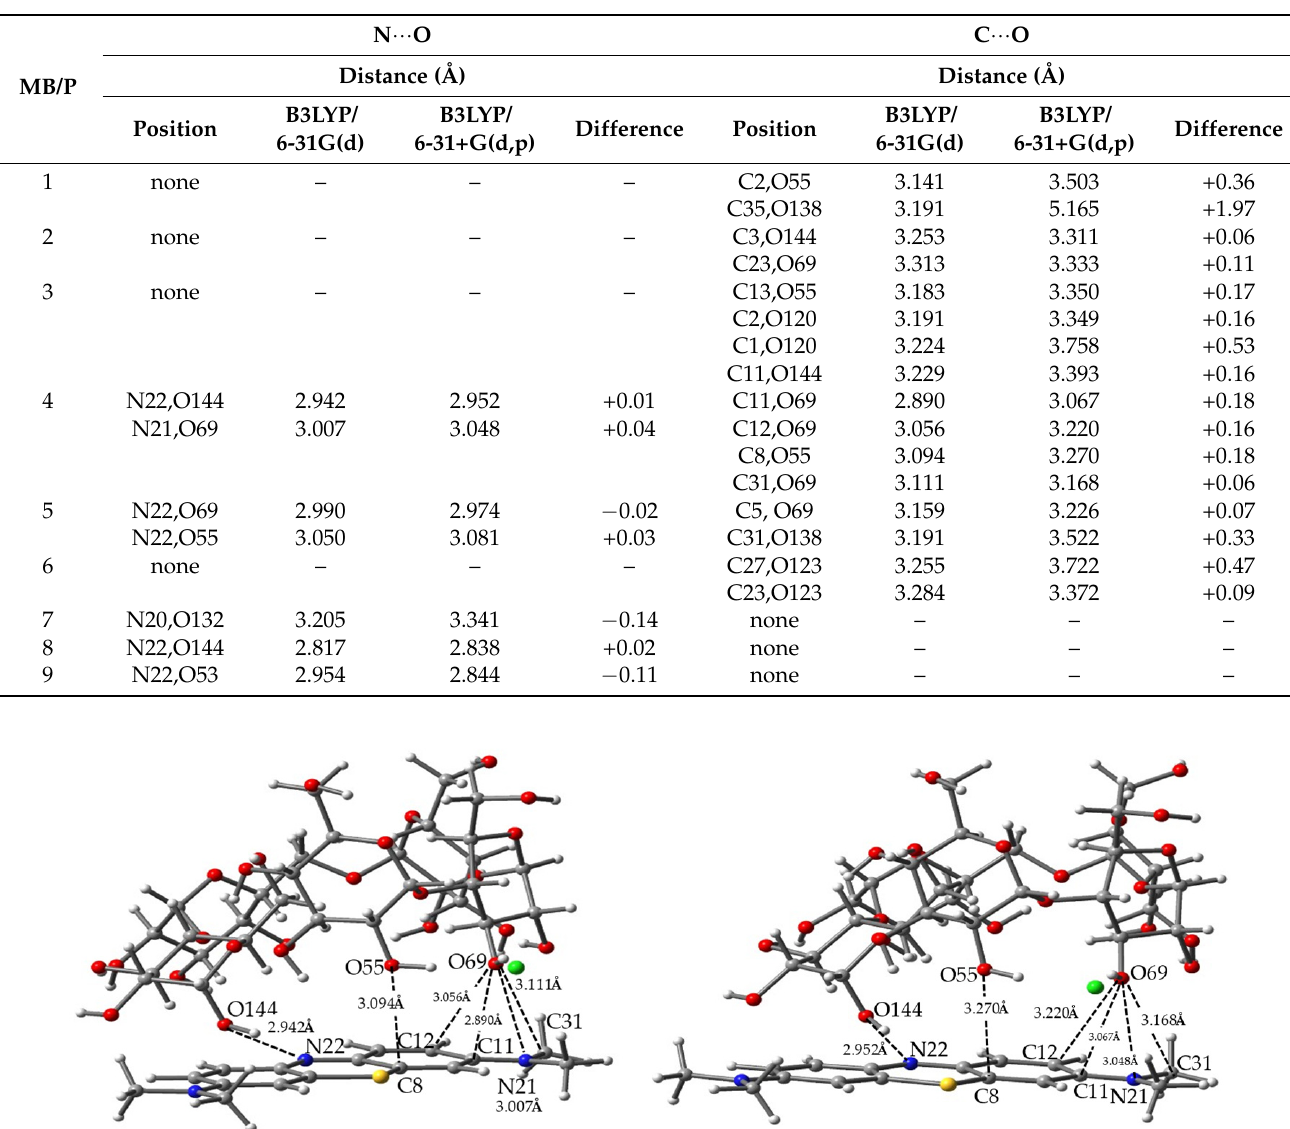
Table 2. Intermolecular interactions observed for MB/pullulan (MB/P) complex.